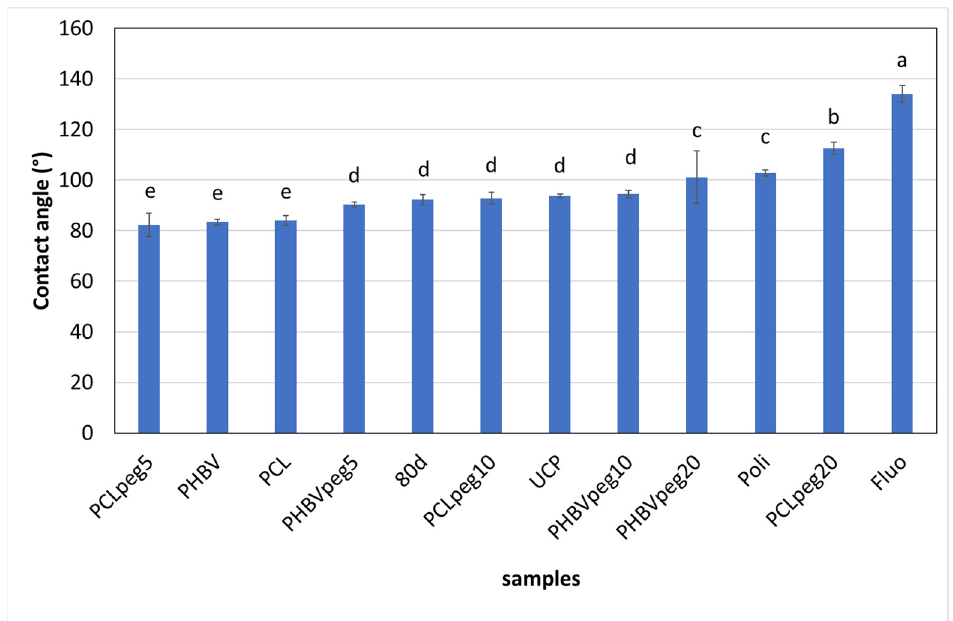
Figure 8. Average water contact angle values for the second set samples. Error bars report standard deviation. Different letters indicate statistically significant differences ( p < 0.05). “UCP” refers to base paper, “Fluo” to fluorinated paper, while “Poli” to polyethylene-coated paper. See Table 1 for other samples codification.